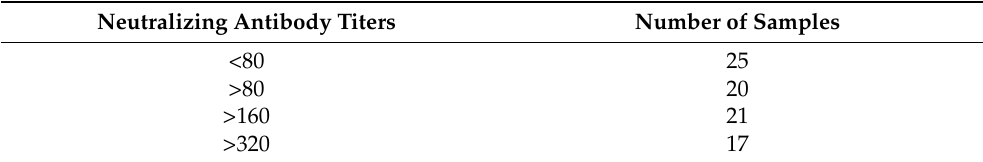
Table 1. Results of the PRNT 50 assay, performed on 83 patients, after healing from severe SARS-CoV-2